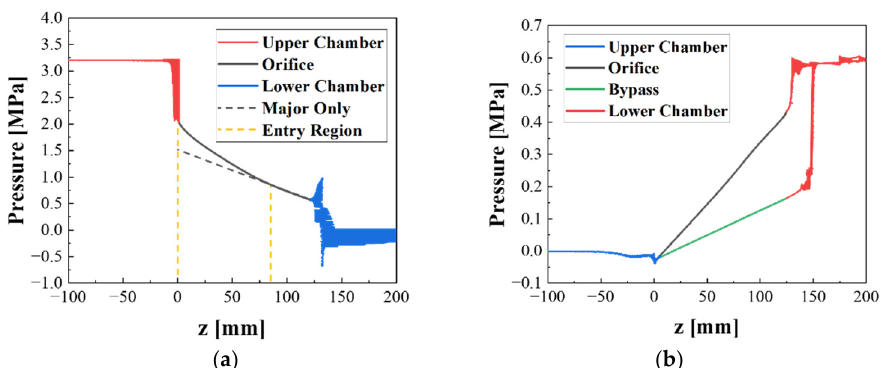
Figure 5. Pressure result calculated with CFD tool, ANSYS Fluent: ( a ) pressure change along the z -axis, compression condition, flow through the orifice, and comparison with major pressure loss; ( b ) pressure change along the z -axis, rebound condition, flow through orifice, and bypass simultaneously.